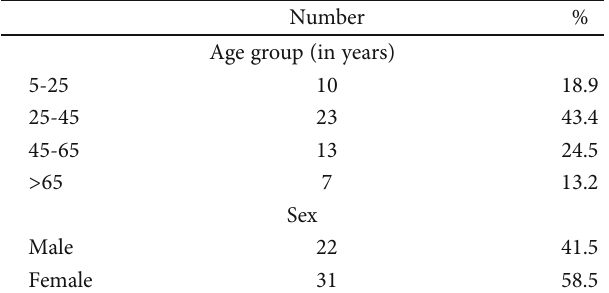
Table 3: Cyst characteristics in USG and CT abdomen.